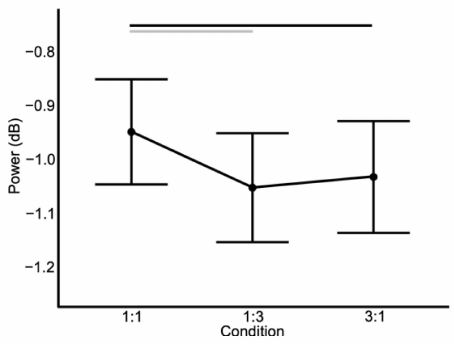
Figure A2. Violin plots of beta power per stage, condition, region, and hemisphere. Lower power values denote higher movement-related beta desynchronization.